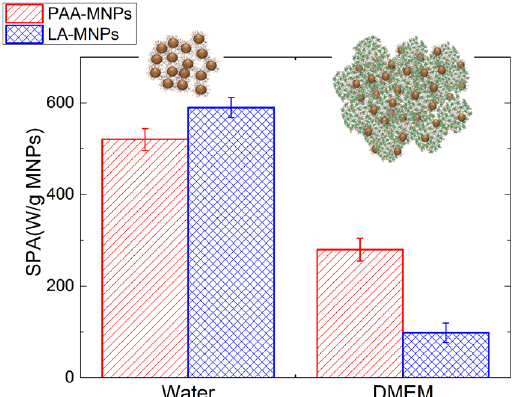
Figure 2. SPA values (H = 23.9 kA/m, f = 560 kHz) of both PAA-MNPs and LA-MNPs, as prepared and after dispersing in DMEM cell culture medium.